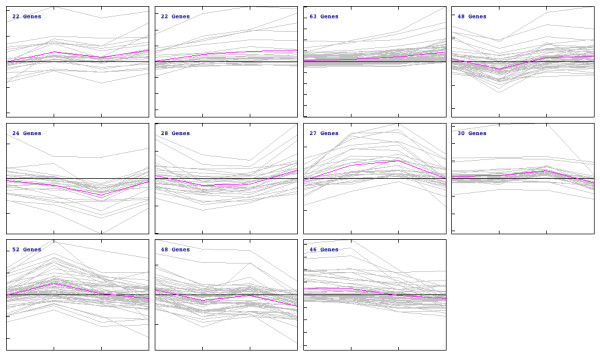
Self organizing tree algorithm (SOTA) clusters of transcription factor transcript levels in response to hypoxia. Eleven clusters were identified in MeV using the SOTA function. Grey lines are the individual transcription factor transcript level, and pink is the average trend line for a given cluster. The majority of transcripts are not associated with a pathway, and therefore no significant categories, other than DNA binding, were detected among the clusters. Each tick mark on the X-axis represents each time point in the experiment, and each tick mark on the Y-axis represents a fold change in transcript level. The box marked with an asterisk represents the cluster containing the known hypoxia responsive transcription factor, SrbA. These transcripts are further evaluated in Figure 13.